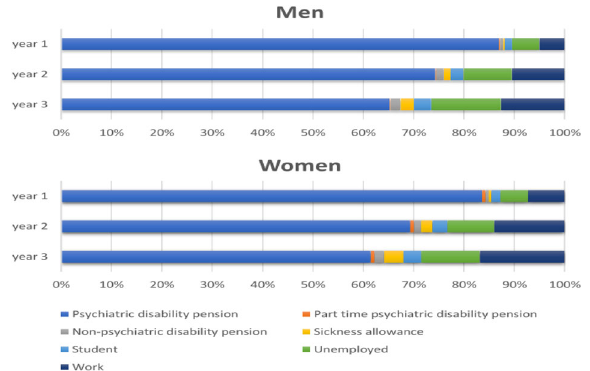
Fig. 2 Situation of people being granted a temporary disability pension between 2010 and 2012 for mental disorders after 1 – 3 years of pensioning, for men ( n = 3613) and women ( n = 5002). This fi gure is covered by the CC BY-NC-ND